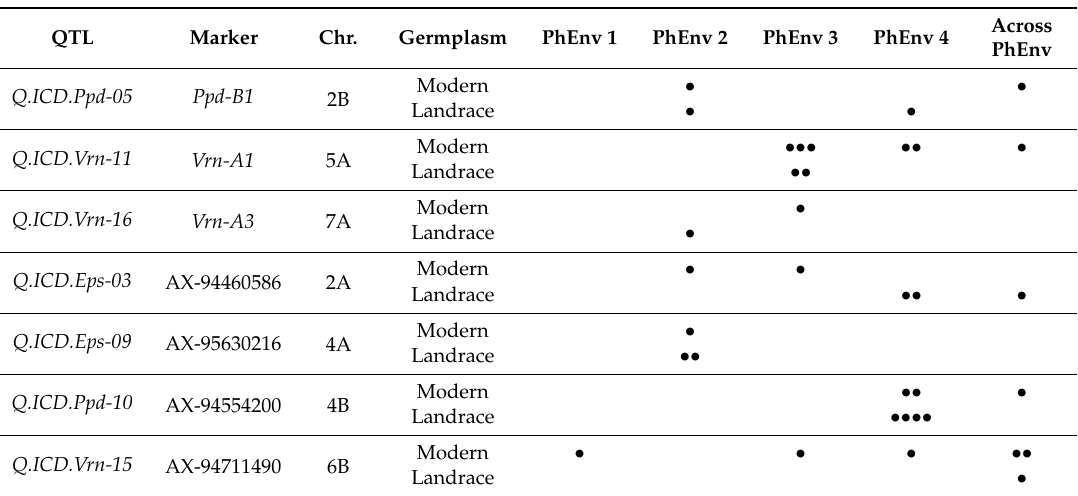
Table 2. Significant QTLs and known flowering genes for landraces and modern lines across phenological environment (PhEnv). The numbers of circles explain the total percent of variance for days to heading explained by each QTL ( • < 5%, •• < 10%, ••• < 20%, •••• >